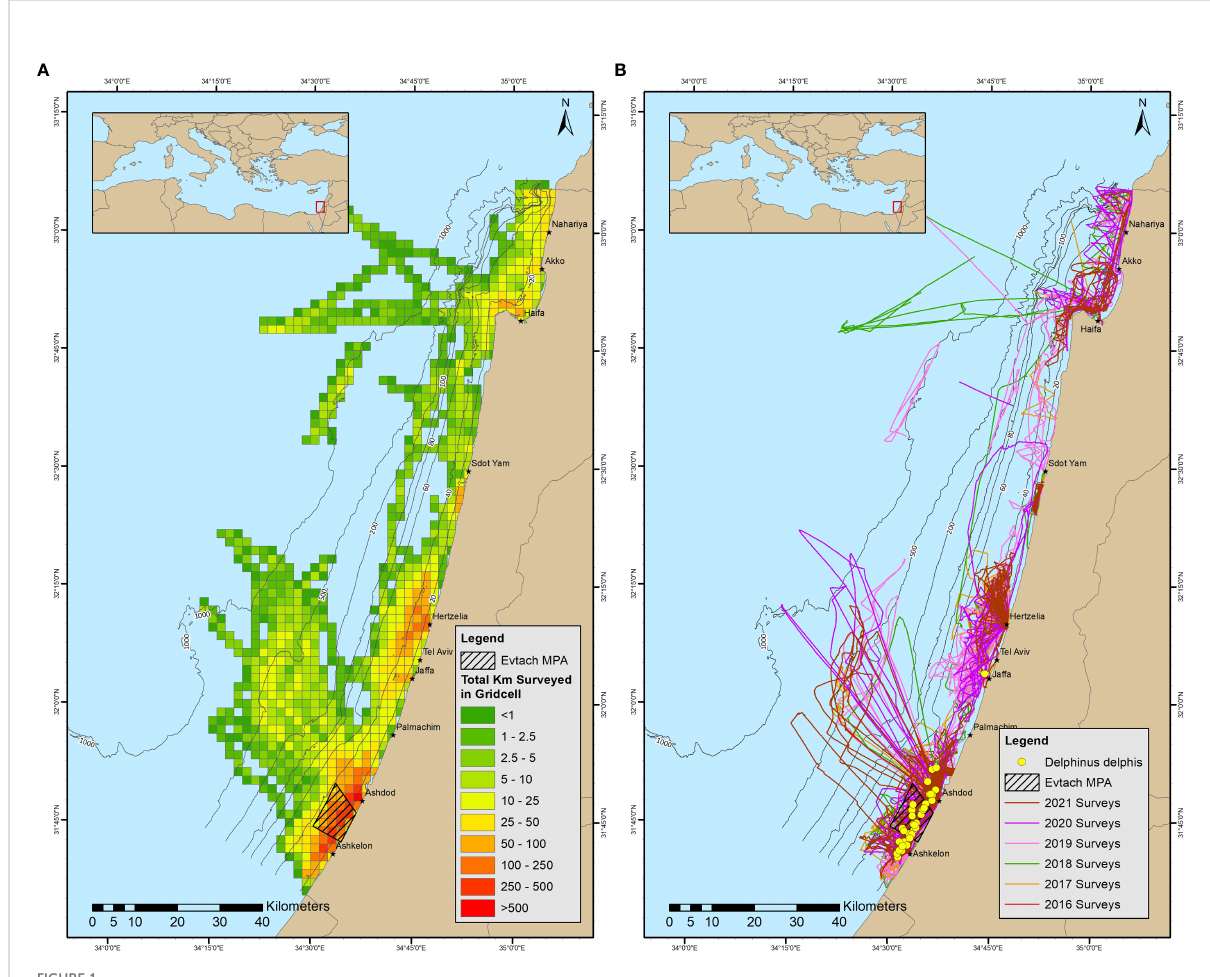
FIGURE 1 (A) Heatmap of survey effort. Colors represent effort in surveyed km in 2x2 grid cells. (B) Survey routs throughout the study period. Different colors represent different years. Yellow circles represent common dolphin